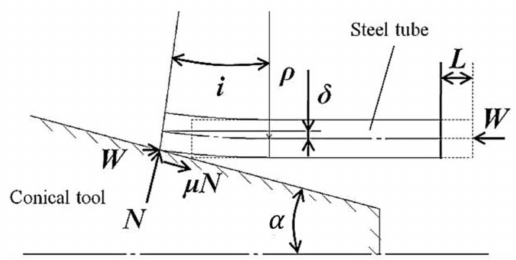
Figure 5. Schematic diagram of flaring test when yield occurred.